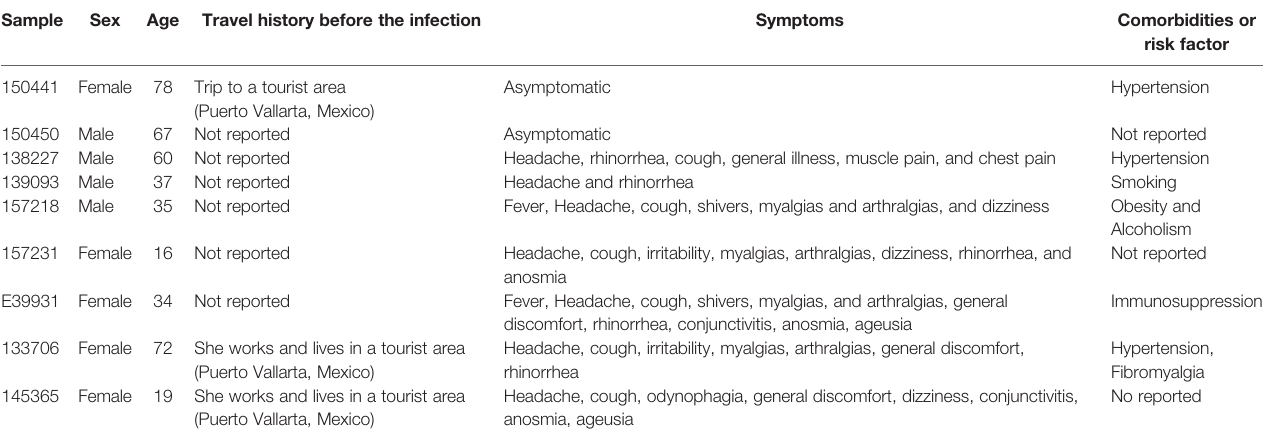
TABLE 4 | Clinical characteristics of COVID-19 patients with presence of SARS-CoV-2 E484K mutation. Sample